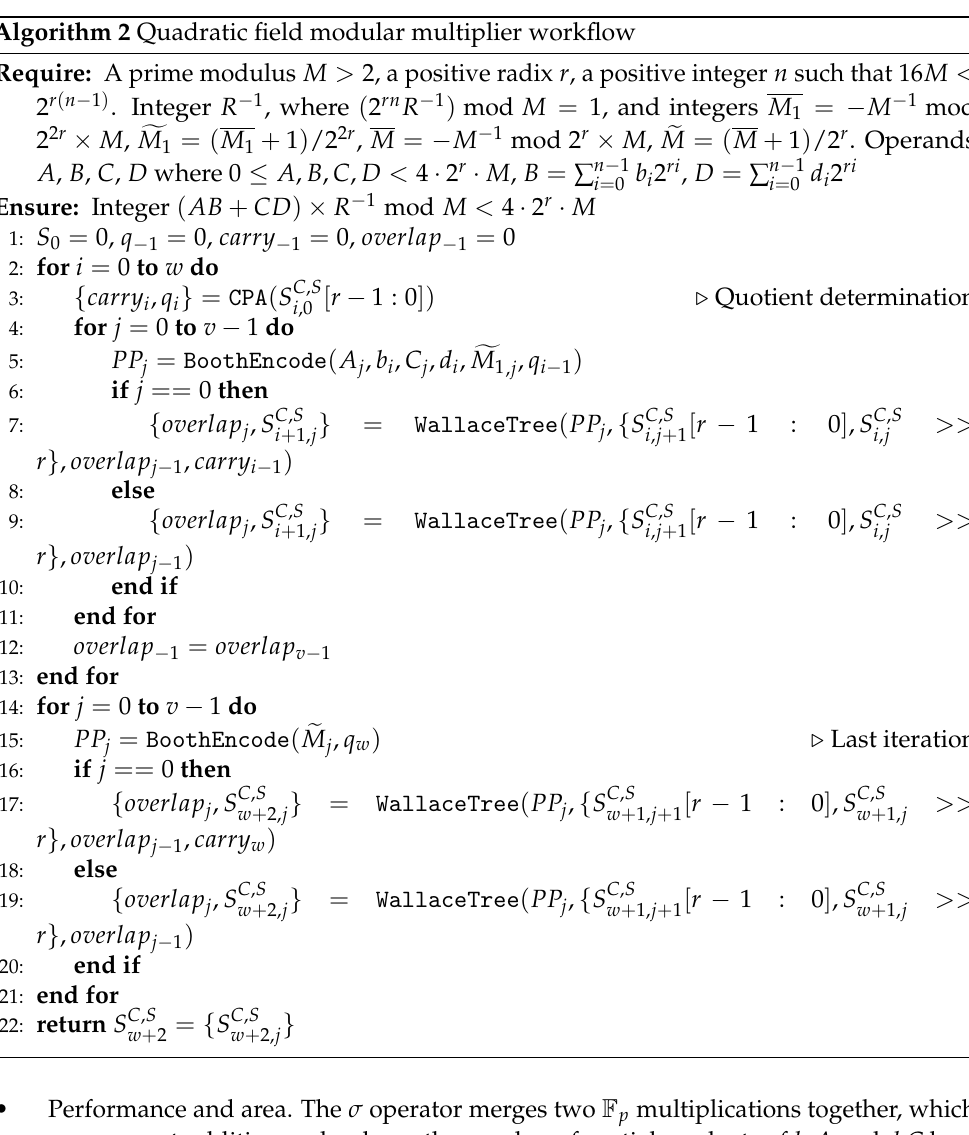
Algorithm 2 Quadratic field modular multiplier